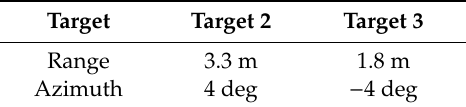
Table 4. Target positions in Experiment 1.